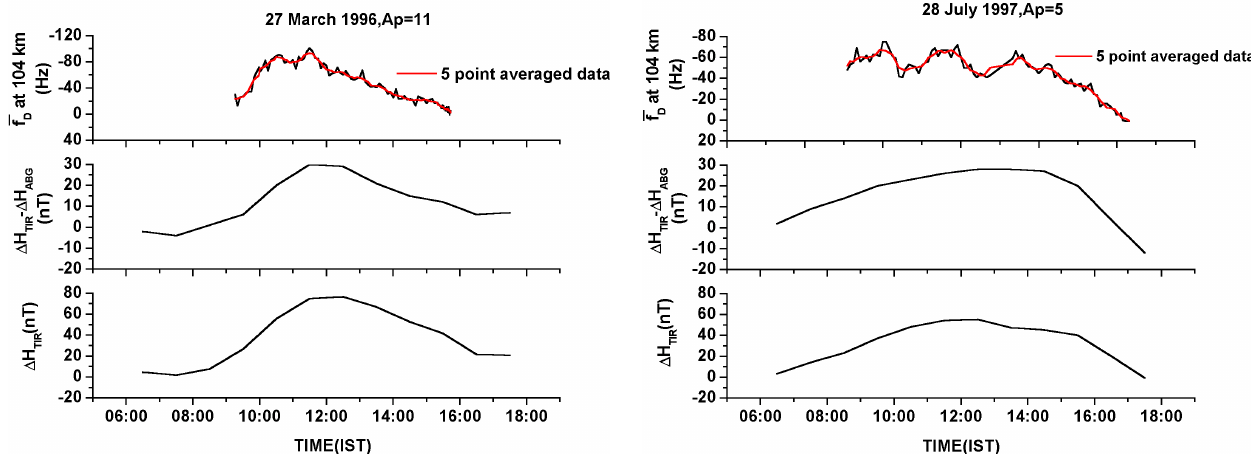
− f D ) values in the EEJ corresponding to 104km on a typical day (27 March 1996) during Fig. 1. VHF radar measured Doppler frequency ( equinoctial period and a typical day (28 July 1997) during solstitial period along with the 1 H TIR and 1 H TIR − 1 H ABG values corresponding to the same days.